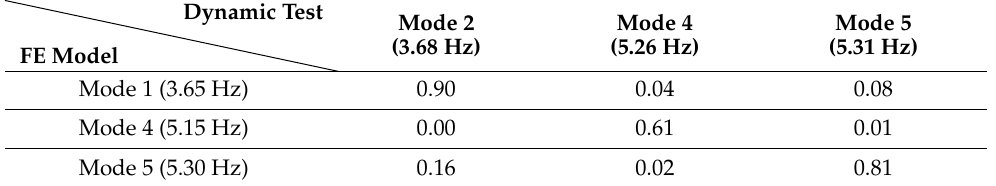
Table 8. MAC values for MODEL_2 and